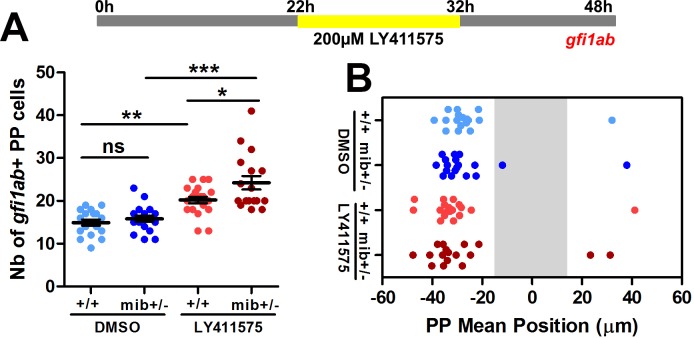
Effect of treatment with high dose of γ-secretase inhibitor from 22 to 32 hpf on the specification and migration of parapineal cells.(A, B) Upper panel shows a schematic of LY411575 treatment timeline: wild-type (+/+) or mib+/- embryos were treated from 22 to 32 hpf with 200 µM of LY411575. Dot plots show the number (A) and the mean position (B) of gfi1ab expressing cells at 48 hpf in the parapineal of DMSO-treated controls (dark blue dots; n = 18), DMSO treated mib+/- (light blue dots; n = 18), LY411575 treated (dark red dots; n = 20) and LY411575 treated mib+/- (light red dots, n = 17); dots represent individual embryos. *** p-value<0.0001, ** p-value<0.01, * p-value<0.05, Welch t-test and Wilcoxon test; Data corresponds to one experiment.